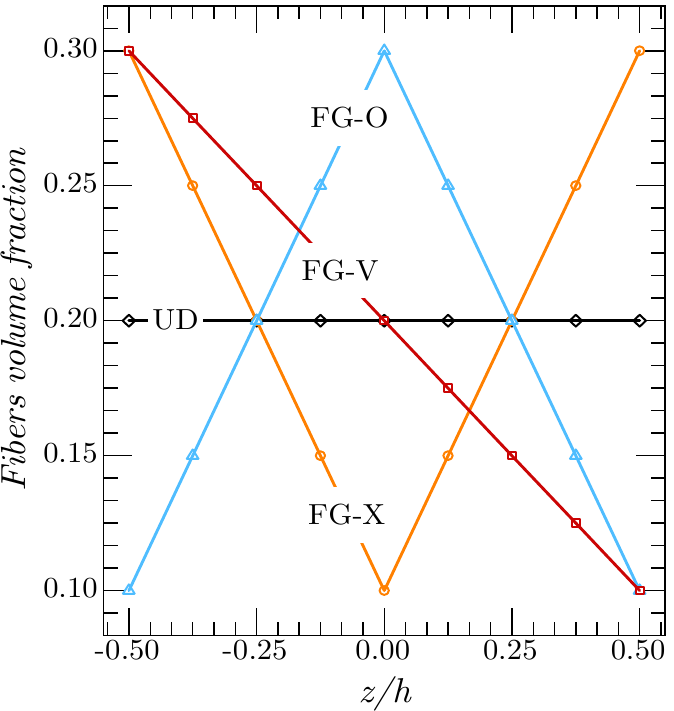
(cid:3040)(cid:3028)(cid:3051)(cid:3033) = 0.3 (cid:3040)(cid:3036)(cid:3041)(cid:3033) = = , 𝑉 min